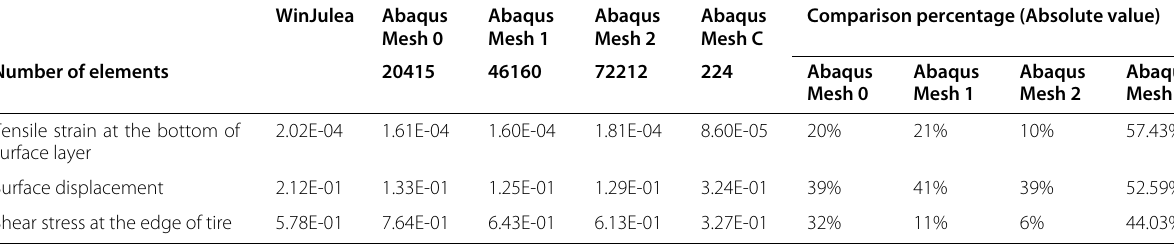
Table 6 Comparison of FEA results with WinJULEA